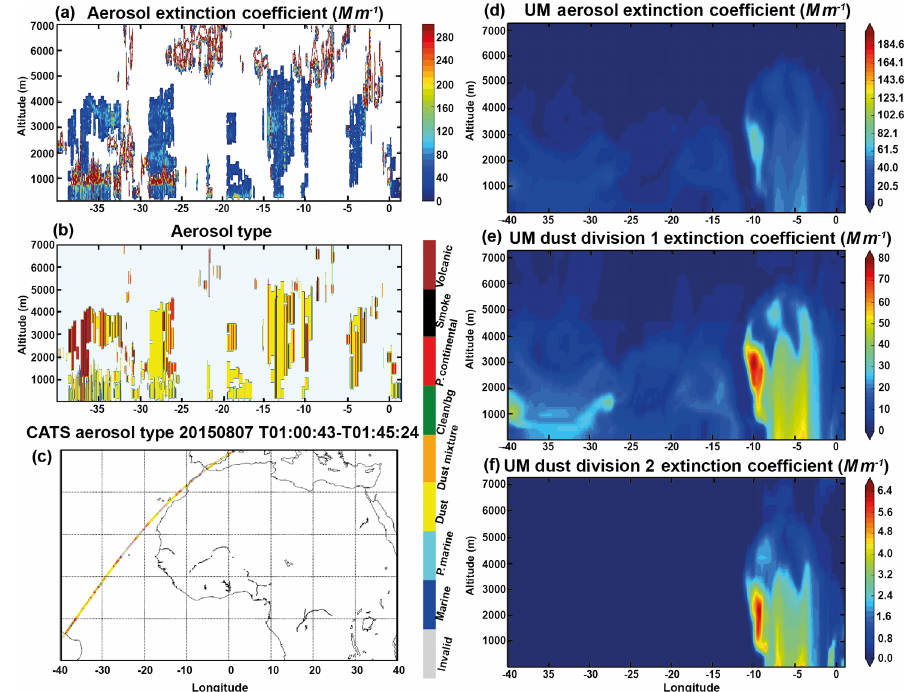
Figure 20. (a–c) CATS and (d–f) MetUM data for 00:00Z on 10 August in the form of vertical cross sections along the satellite track: (a) CATS aerosol extinction coefficient; (b) CATS feature type; (c) CATS overpass track; (d) MetUM total dust extinction coefficient; ( (e) MetUM d1 dust extinction coefficient; and (f) MetUM d2 dust extinction